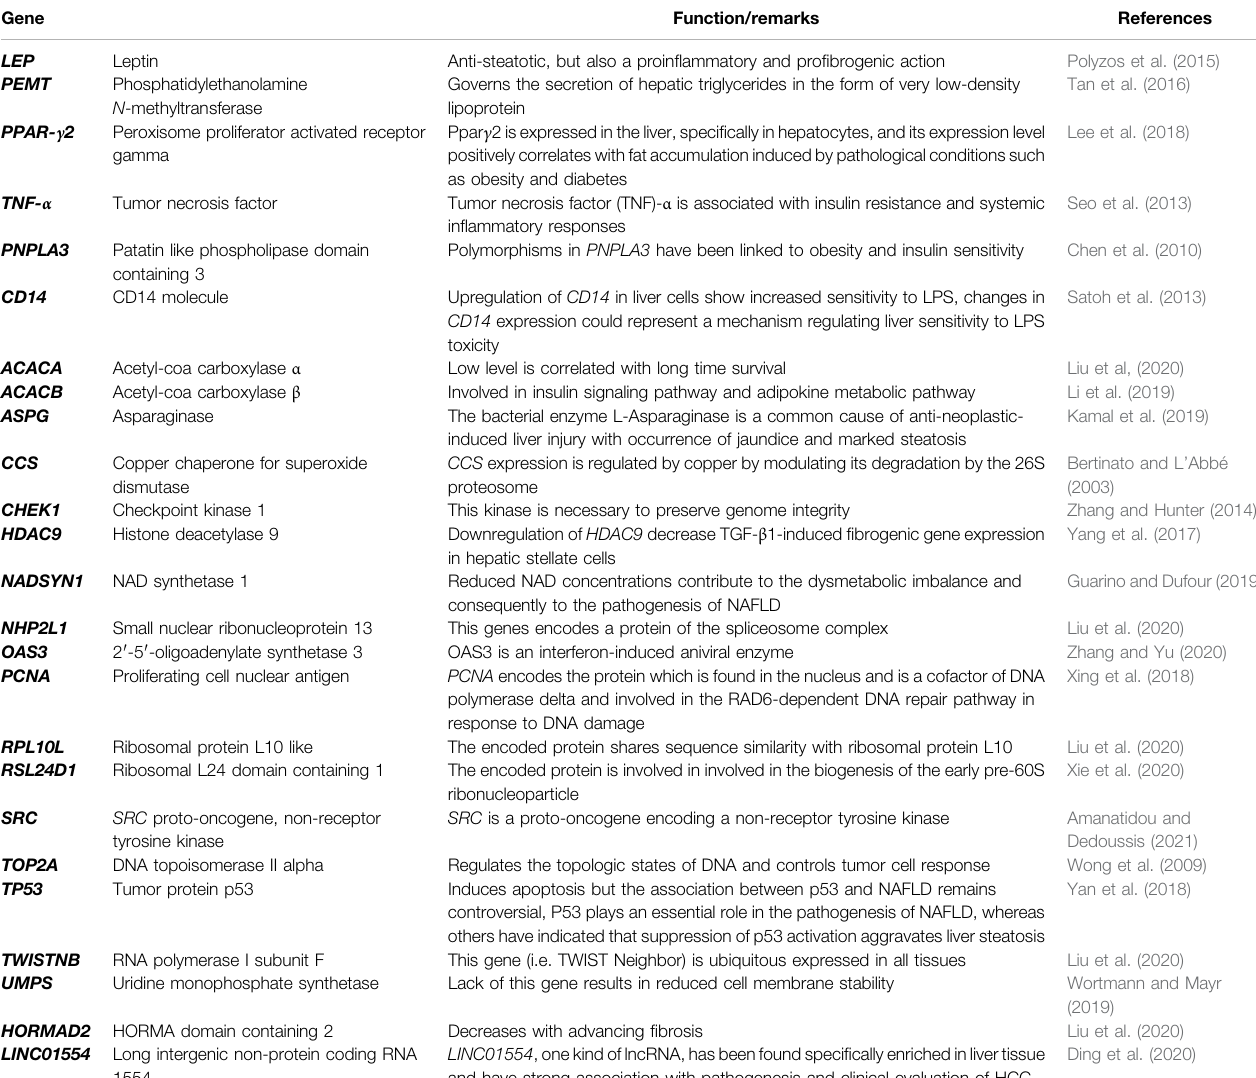
TABLE 2 | Summary of pathways from transcriptomics analyses implicated in